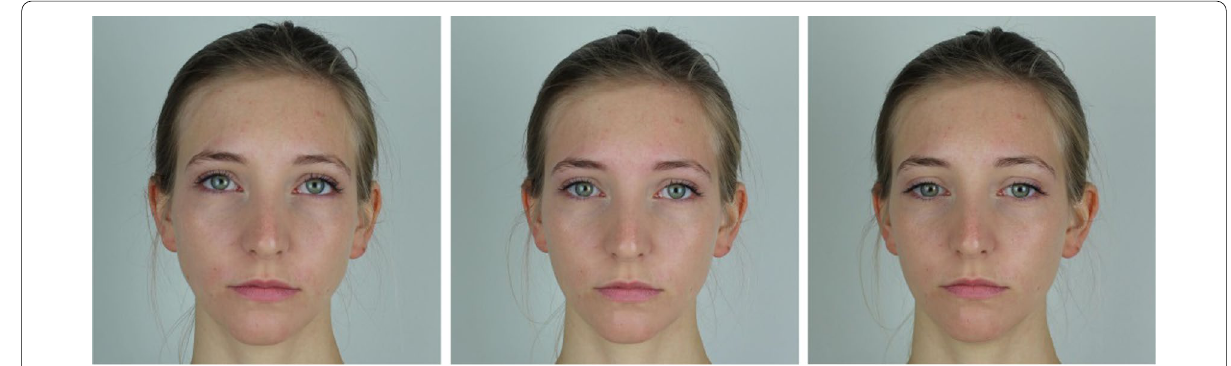
Fig. 2 Three examples for the looker model in Experiment 1. Left: 9° upward; middle: gaze straight at the camera; right: 12° downward